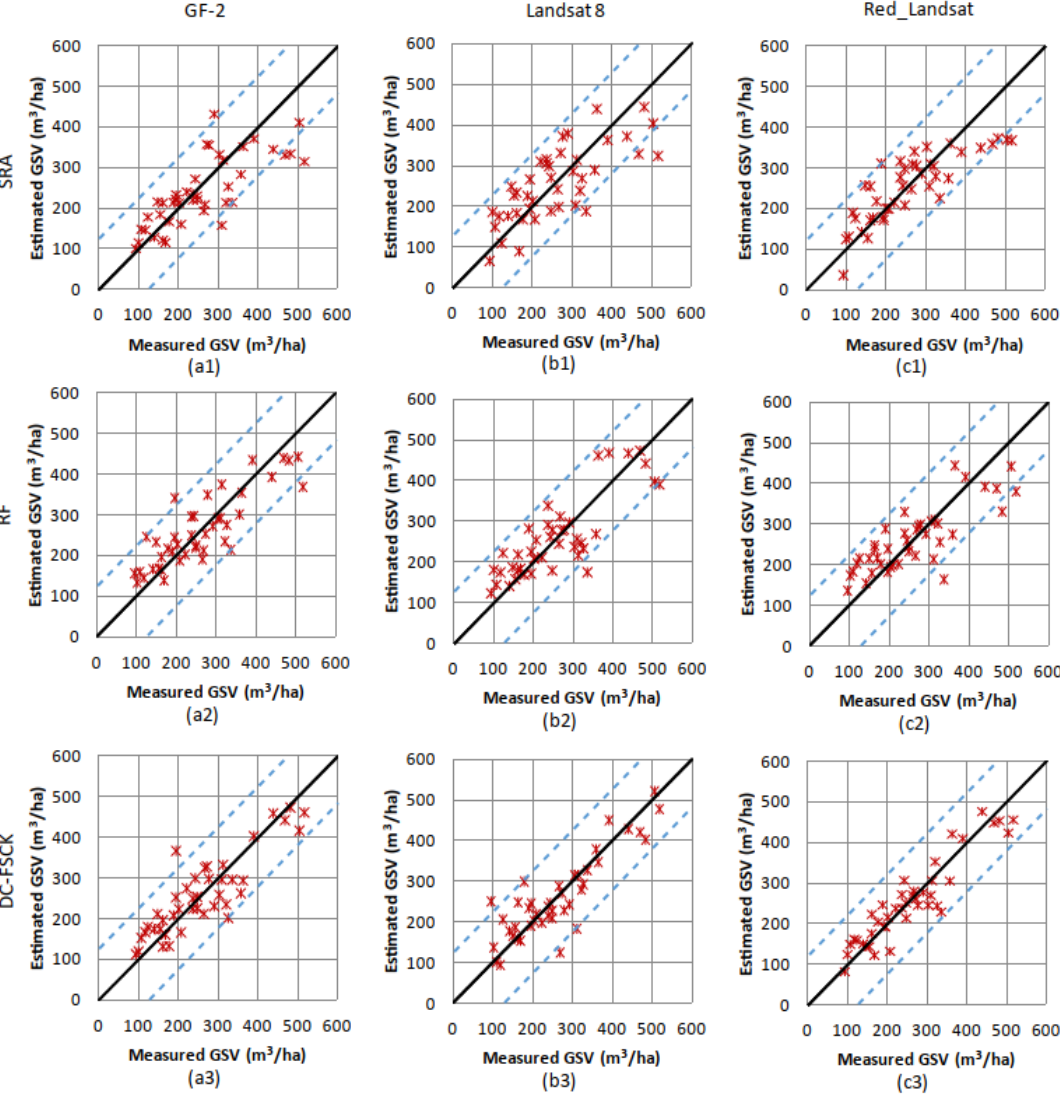
Figure 3. The scatter graphs between the observed and estimated GSV values of the Chinese pine plots using three datasets and three variable screening methods (SRA, RF, and DC-FSCK): ( a , b , c ) are the GSV estimated by the GF-2, Landsat 8, and Fusion image Red_Landsat, respectively; ( 1 , 2 , 3 ) are the GSV estimated using the variables selection methods SRA, RF, and DC-FSCK, respectively. Each graph corresponds to the best estimation model with the smallest RMSEr value for each data scenario in Table 6. The black diagonal line is the theoretical best fit reference line, and the blue parallel dashed lines are the estimation residual reference lines with a 50% deviation from the sample mean.